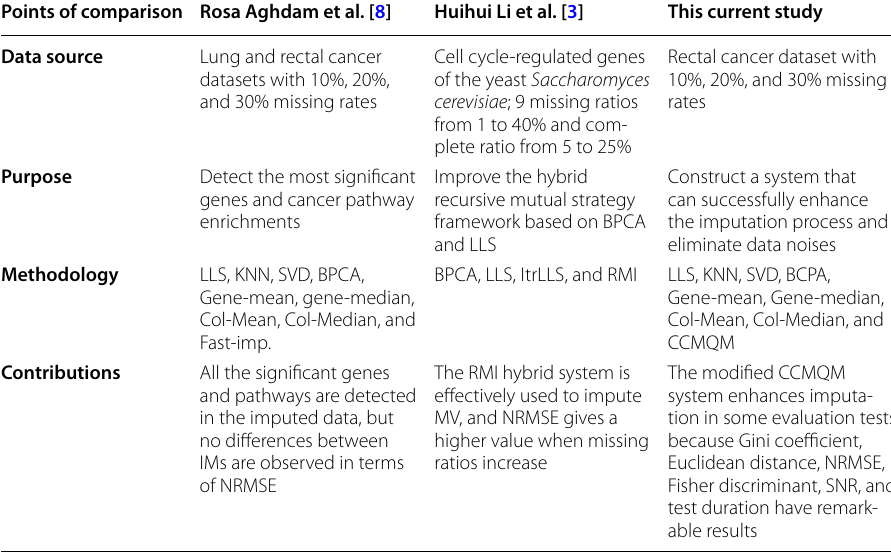
Table 3 A comparison of results with other previous studies Points of comparison Rosa Aghdam et al.